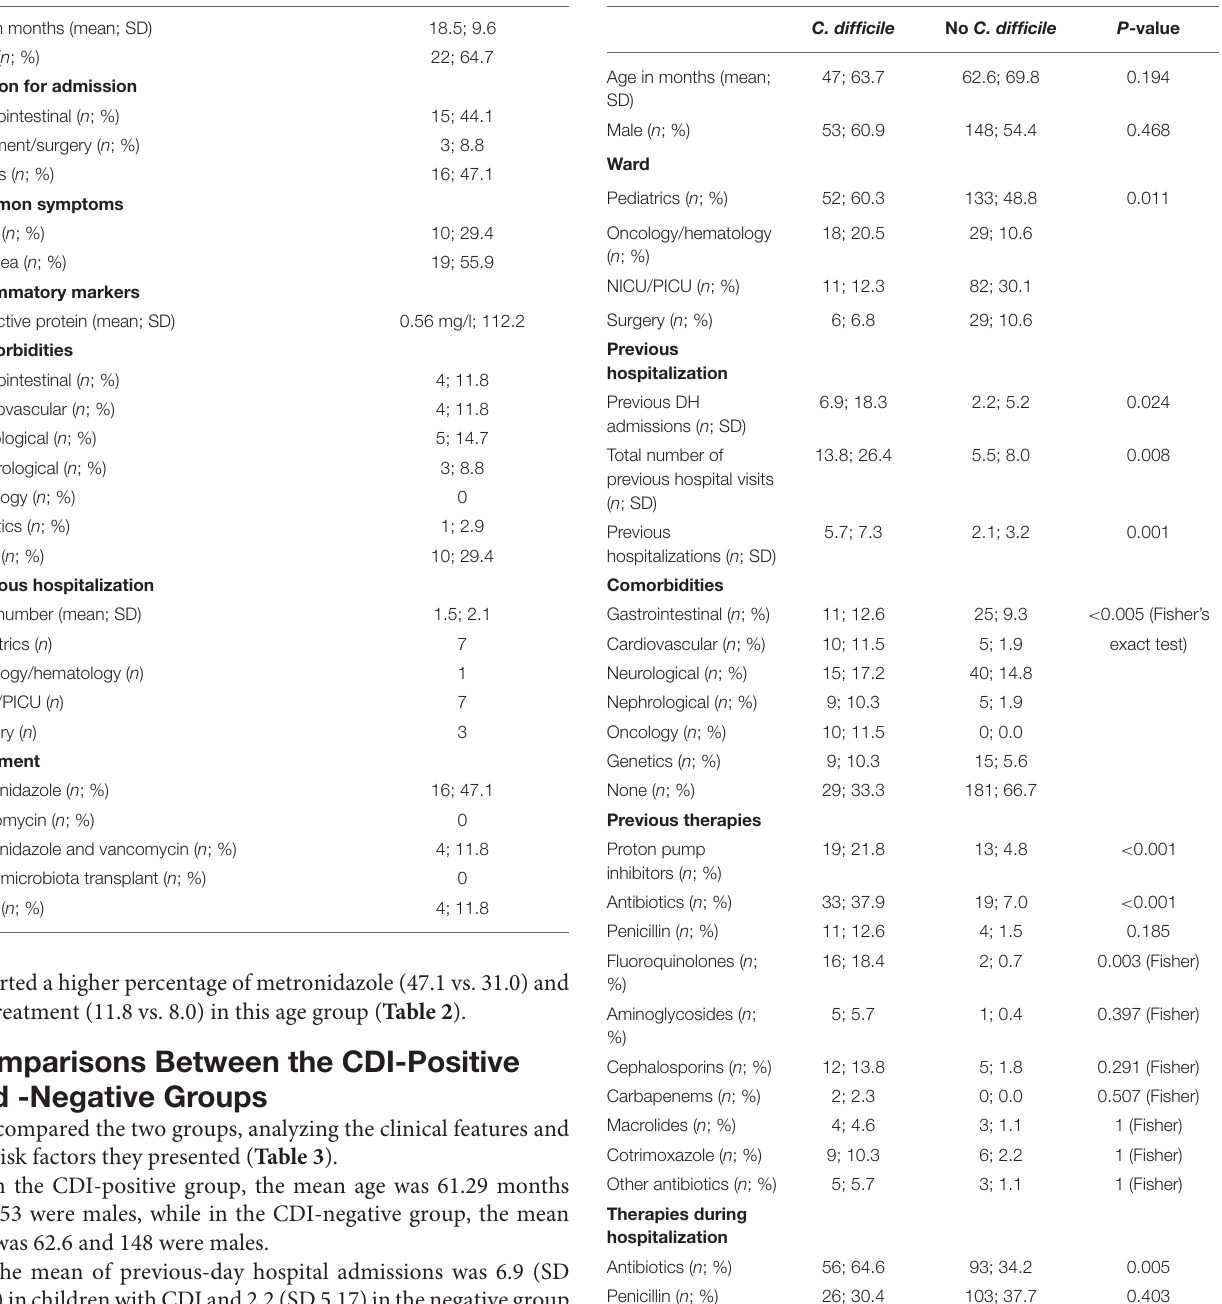
TABLE 2 | Features of patients with CDI and age < 3 years ( n = 34). TABLE 3 | Comparison between CDI-positive and -negative